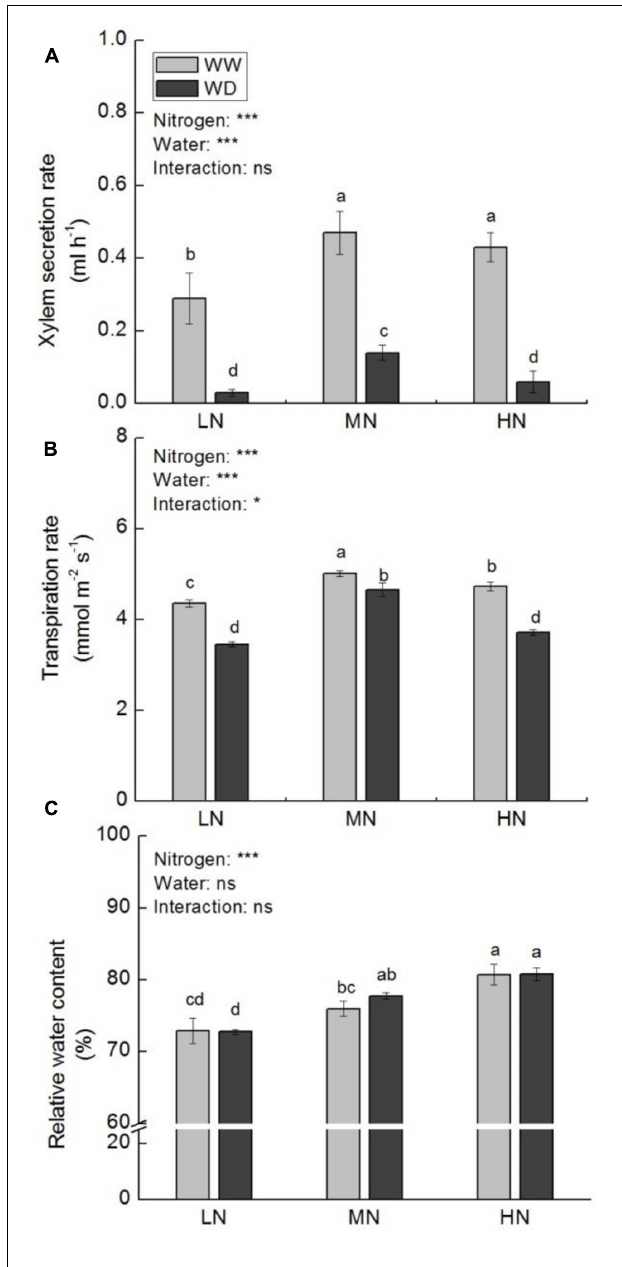
FIGURE 1 | Comparison in xylem secretion rate (A) , transpiration rate (B) , and leaf relative water content (RWC) (C) in rice plants grown under different nitrogen and water conditions. Data refers to mean ± SE ( n = 4). P -values of the two-way ANOVAs of nitrogen, water, and their interaction are indicated: ns, not significant; ∗ P < 0.05; ∗∗ P < 0.01; ∗∗∗ P < 0.001. Bars with the same letter are not significantly different by LSD test. WD, water deficit; WW,